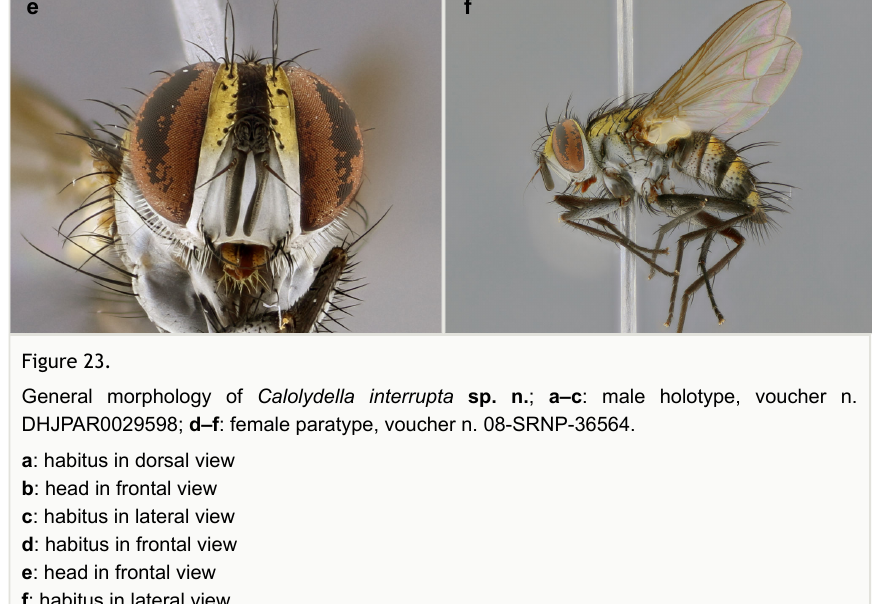
Figure 23. General morphology of Calolydella interrupta sp. n. ; a–c : male holotype, voucher